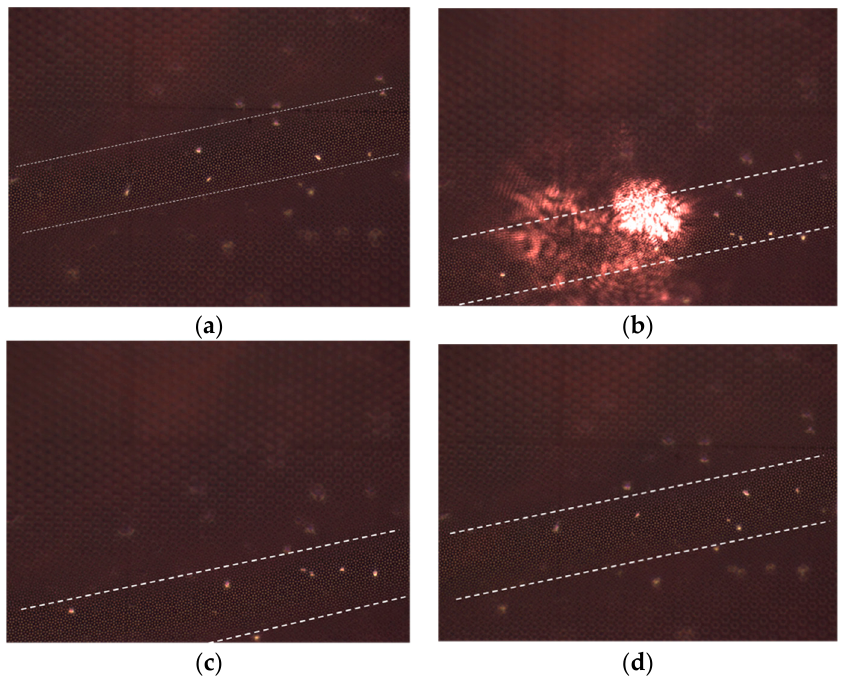
Figure 7. Dark field microscopy analysis of the laser-light-induced motion of a dodecagonal symmetry plasmonic crystal nestled on the PMP film surface. The area in focus of the microscope objective is edged by dashed white lines. ( a ) light off: initial position; ( b ) light on: shift of the focus area under illumination ( λ = 785 nm; power on sample approximately 3 mW); ( c ) light OFF: inertial motion after irradiation; ( d ) light OFF: restoring of the initial position.